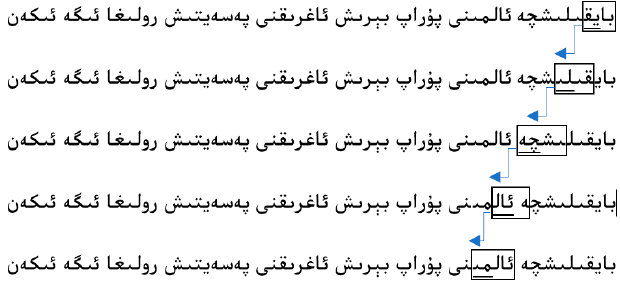
Figure 5. Word-based string scanning.